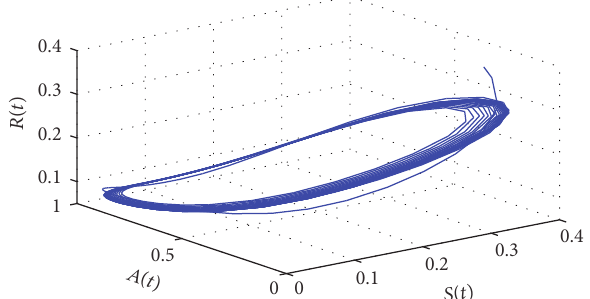
Figure 15: The phase plot of states 𝑆 ∗ , 𝐴 ∗ , and 𝑅 ∗ with 𝜏 1 = 22.4057 > 18.6255 = 𝜏 󸀠